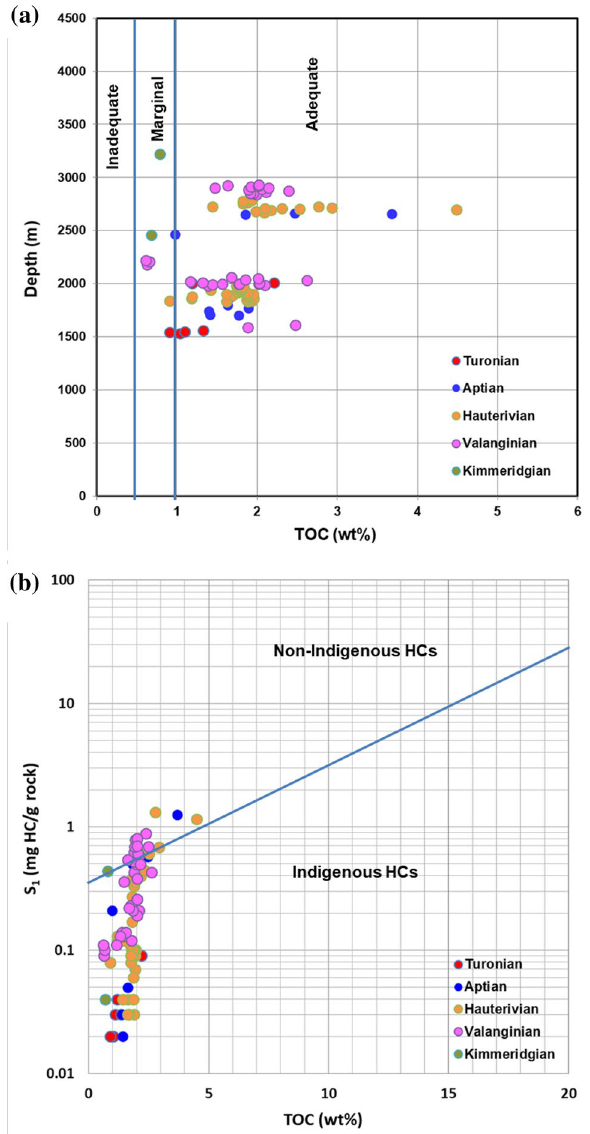
Fig. 6 Analyzed sample distribution plots demonstrating a the total organic carbon (wt%) content versus depth and b indicating indige- nous and non-indigenous hydrocarbons